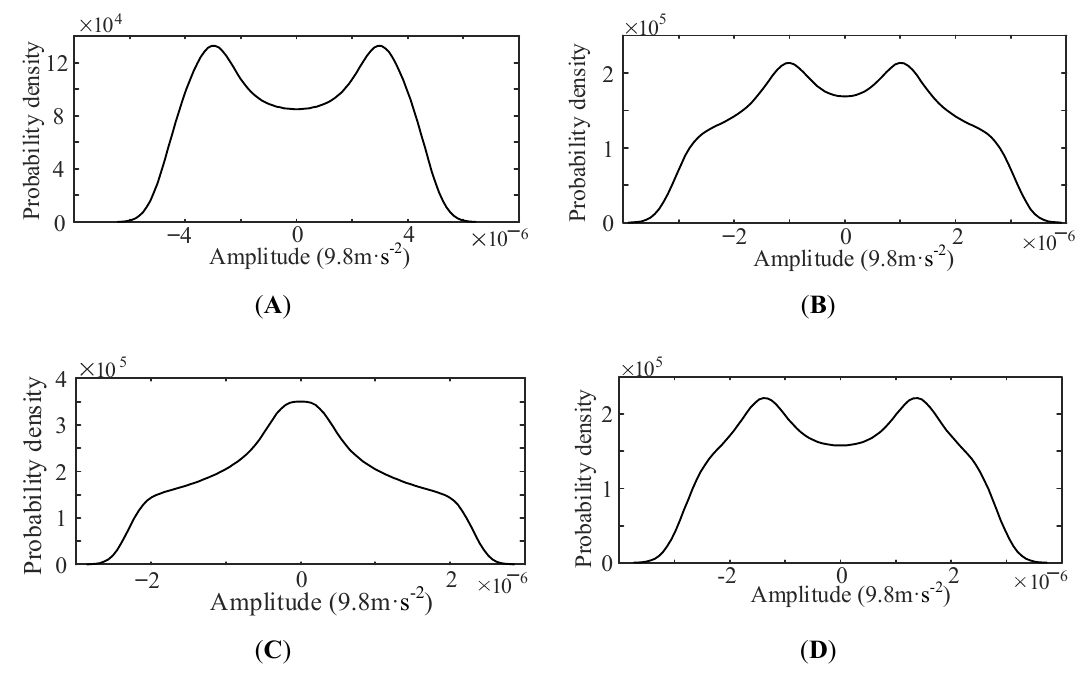
Table 4. Natural frequencies of running propulsion shafting in the linear alignment state.